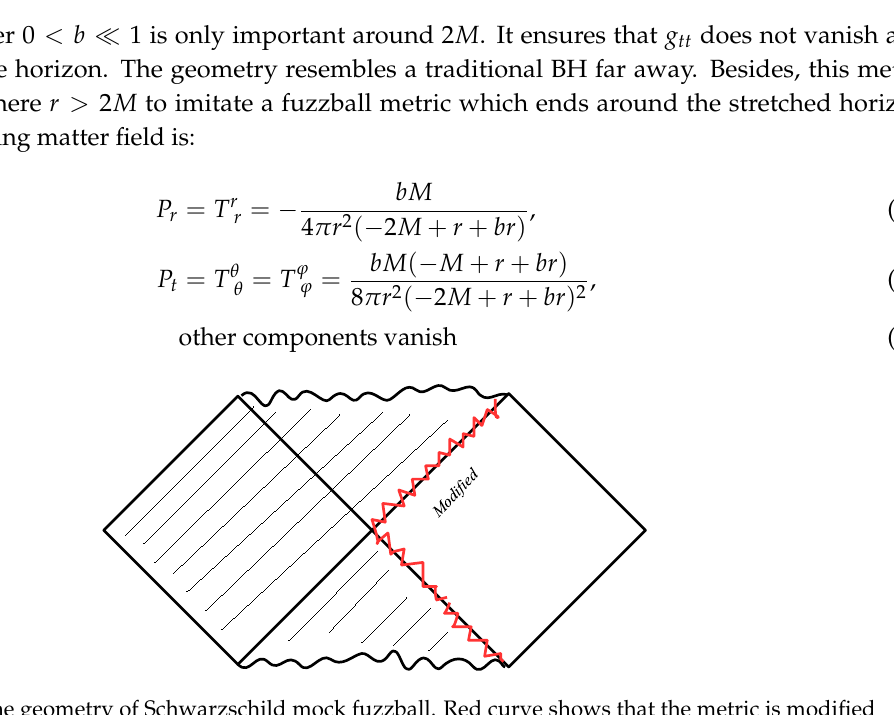
Figure 4. The geometry of Schwarzschild mock fuzzball. Red curve shows that the metric is modified around the horizon, and the shaded area is removed from the